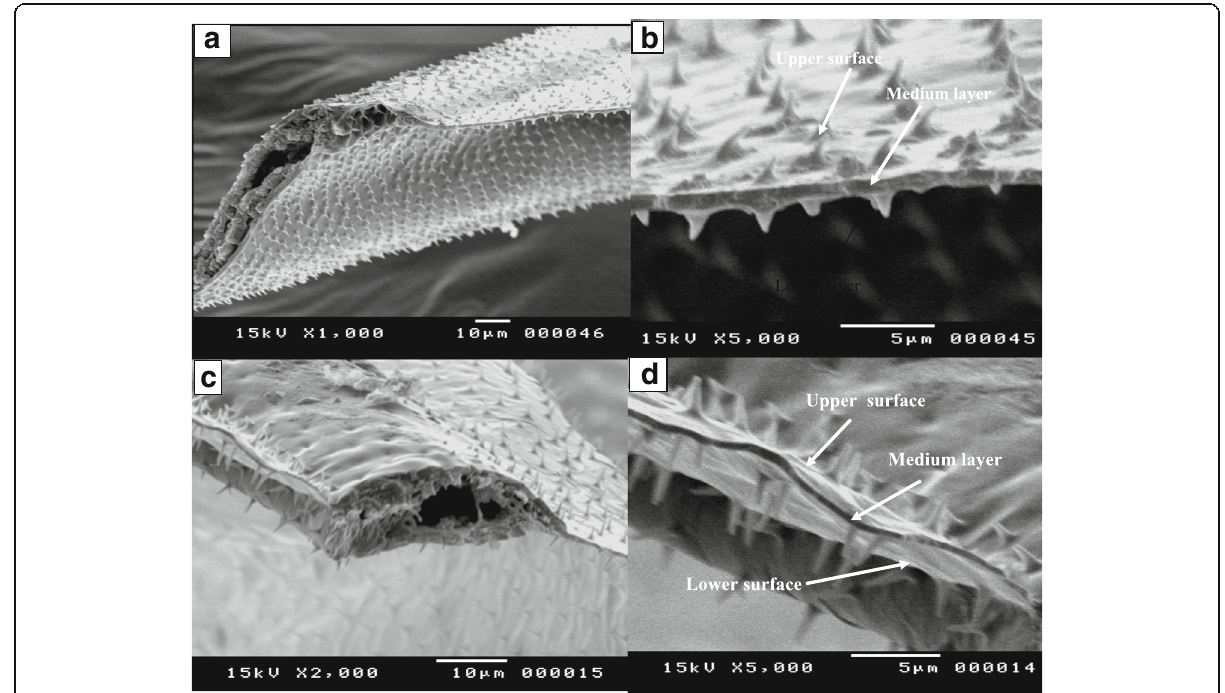
Fig. 5 Scanning electron microscope (SEM) images of cross section of hindwing of a , b Tribolium castanaeum and c , d Tribolium